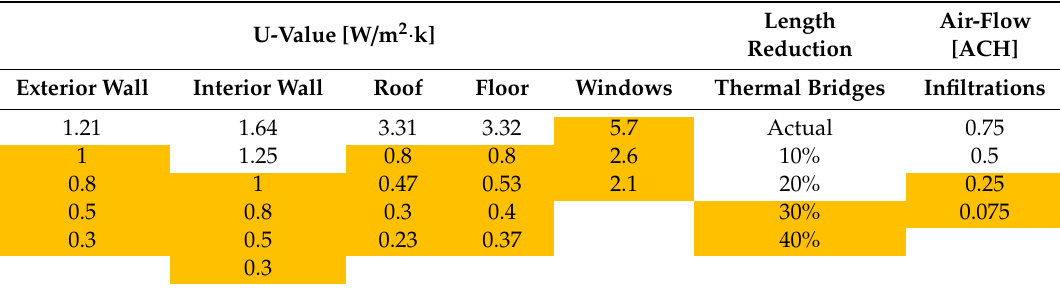
Table 4. Catalog of conventional measures for the buildings’ constructive elements. ACH: Air Changes per Hour.